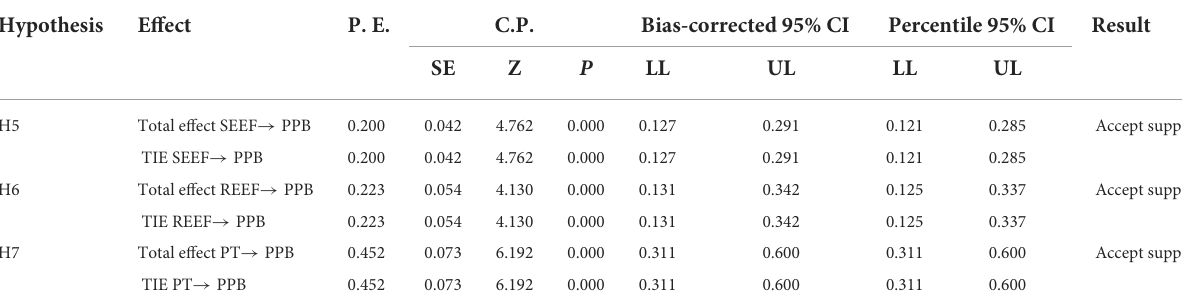
TABLE 3 Indirect effects of privacy